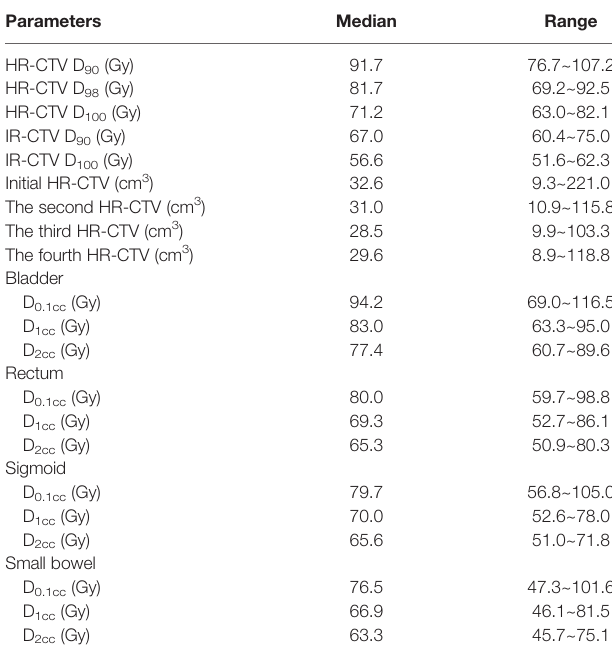
TABLE 2 | Dosimetric